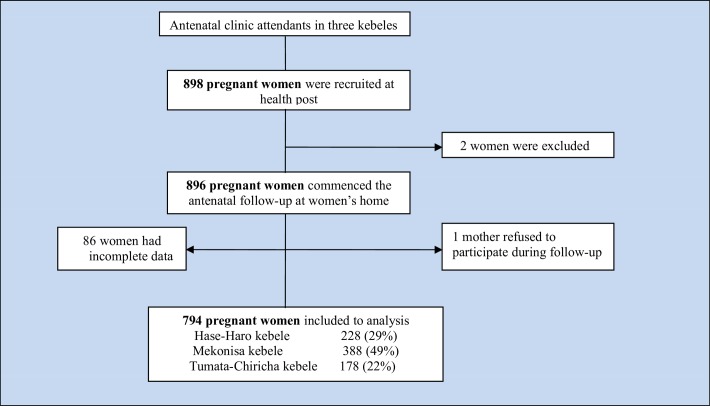
Flowchart of recruitment of pregnant women in rural southern Ethiopia, 2017/18.